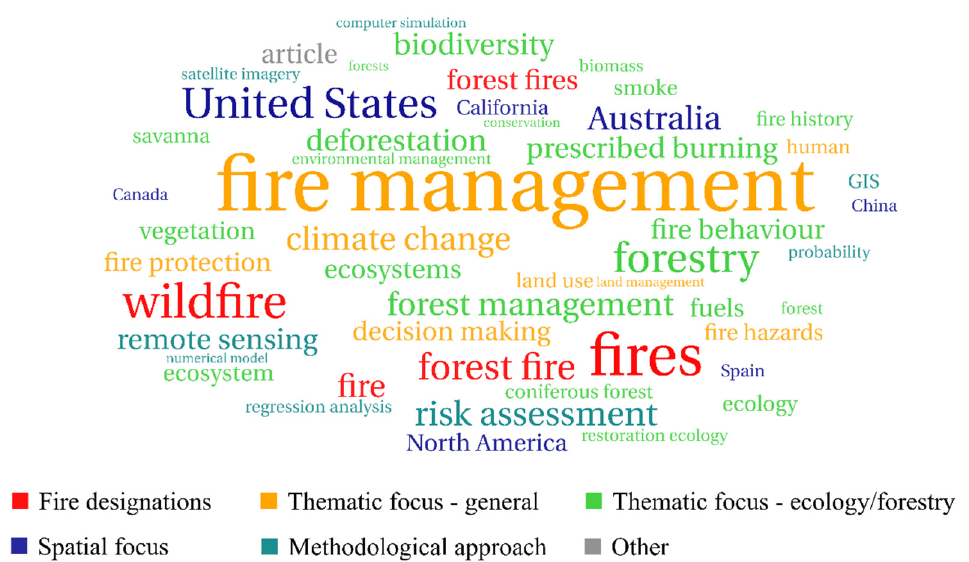
Figure 6. Word cloud made up of keywords used in fire-management publications included in Sco- pus (1973–2021).